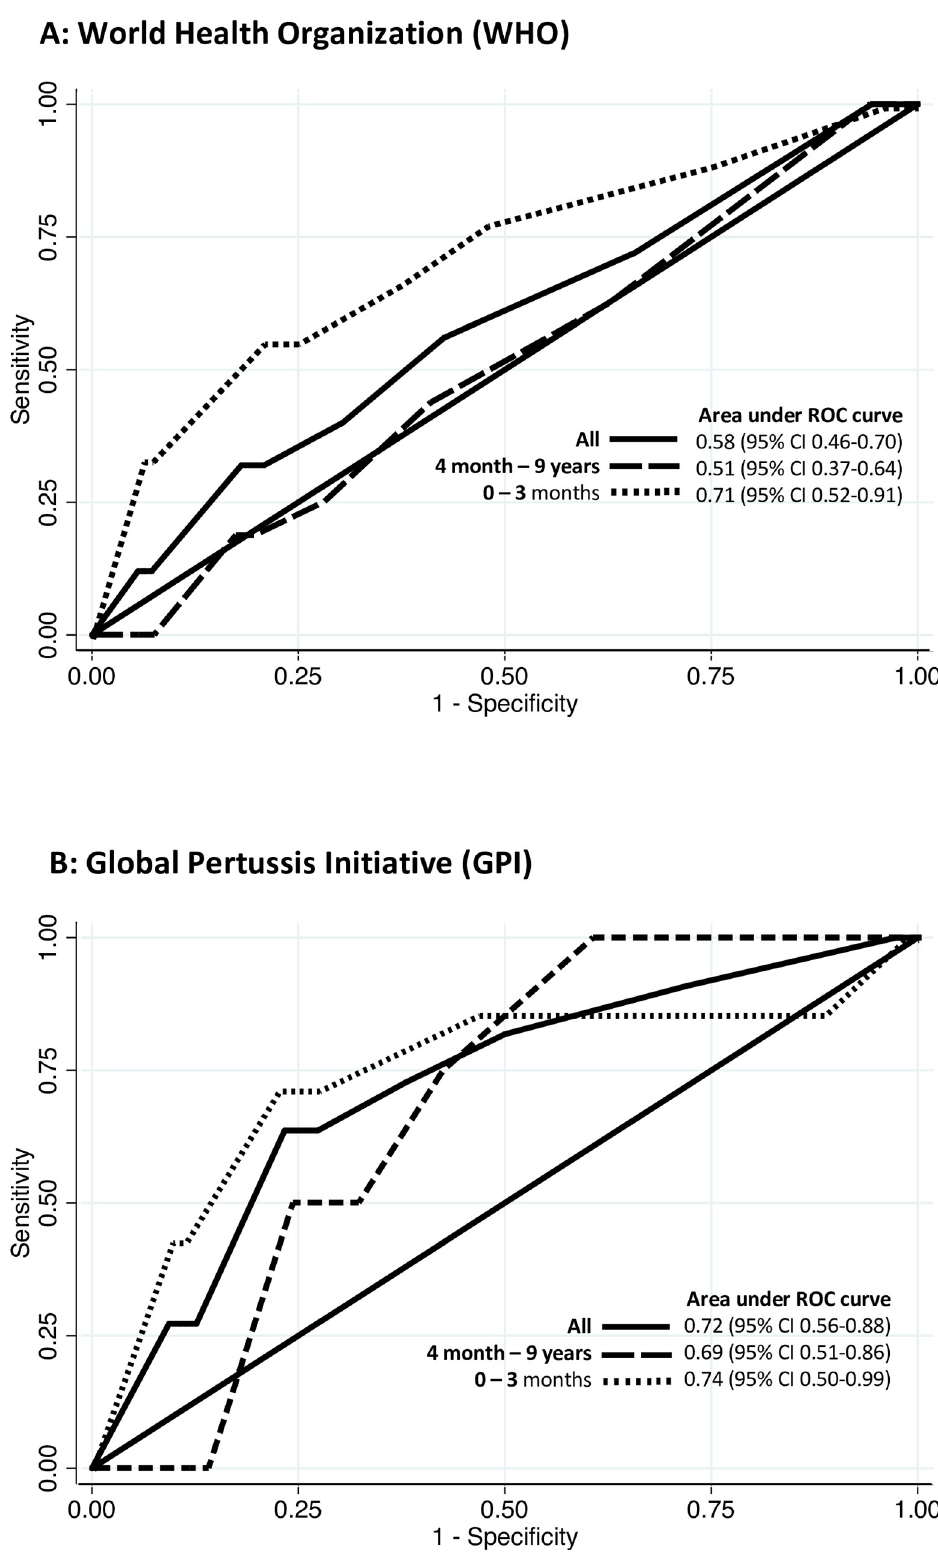
Fig 2. Receiver Operating Characteristics (ROC) curves for duration of symptoms.